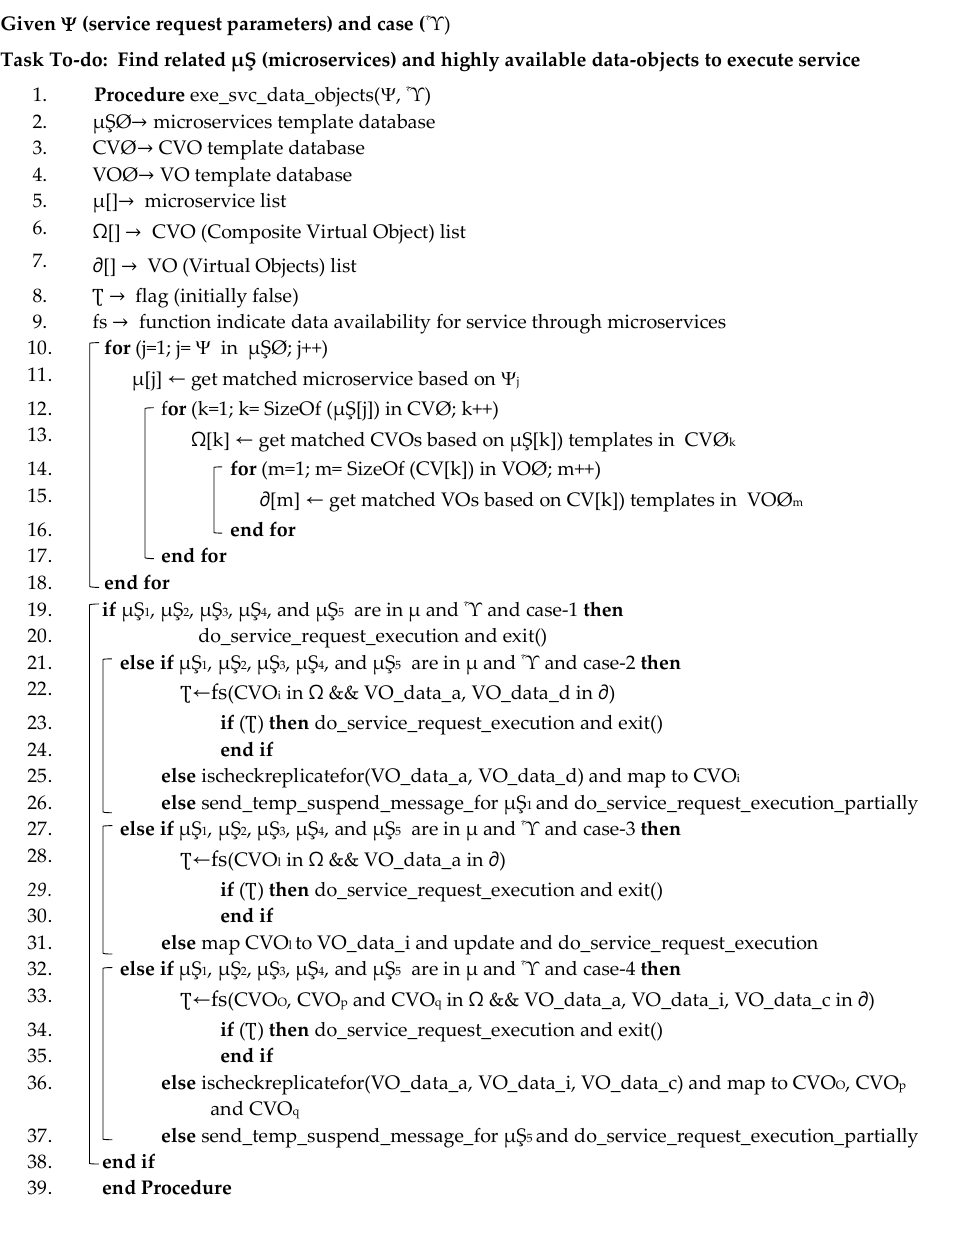
Algorithm 1 Algorithm the enhance data availability for efficient microservices-based service execution